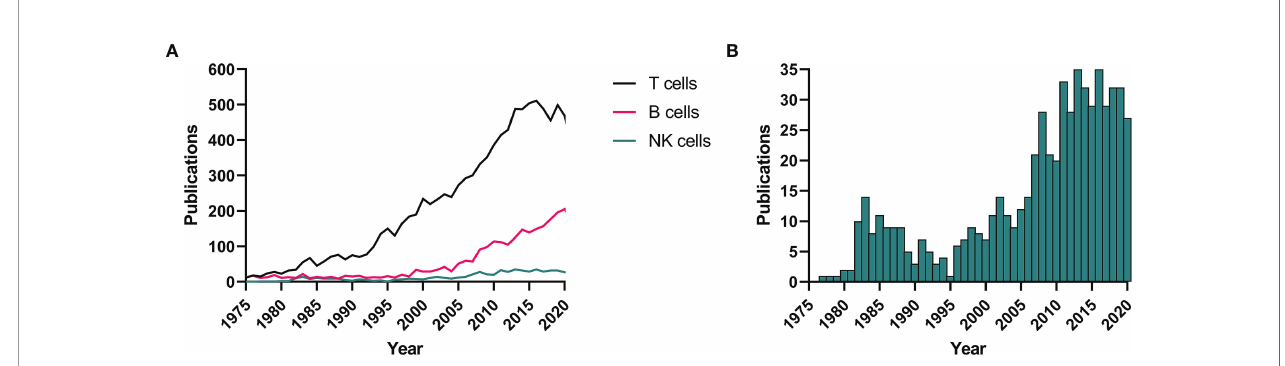
FIGURE 1 | NK cells in MS literature. A systematic literature search in PubMed (NCBI) was performed using the terms “ T cells ” , “ B cells ” , or “ natural killer cells ” + “ multiple sclerosis ” . Results are shown for all three cell types from 1975 to 2020 (A) as well as a close-up for the NK cell results (B) . NK, natural killer; MS, multiple